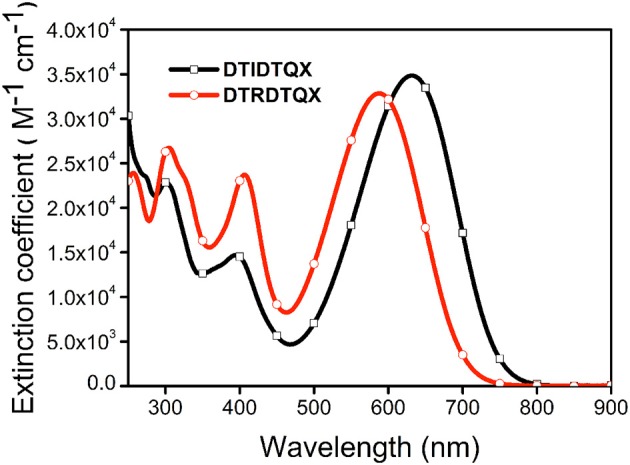
UV-Vis absorption spectra of DTIDTQX and DTRDTQX in CH2Cl2.